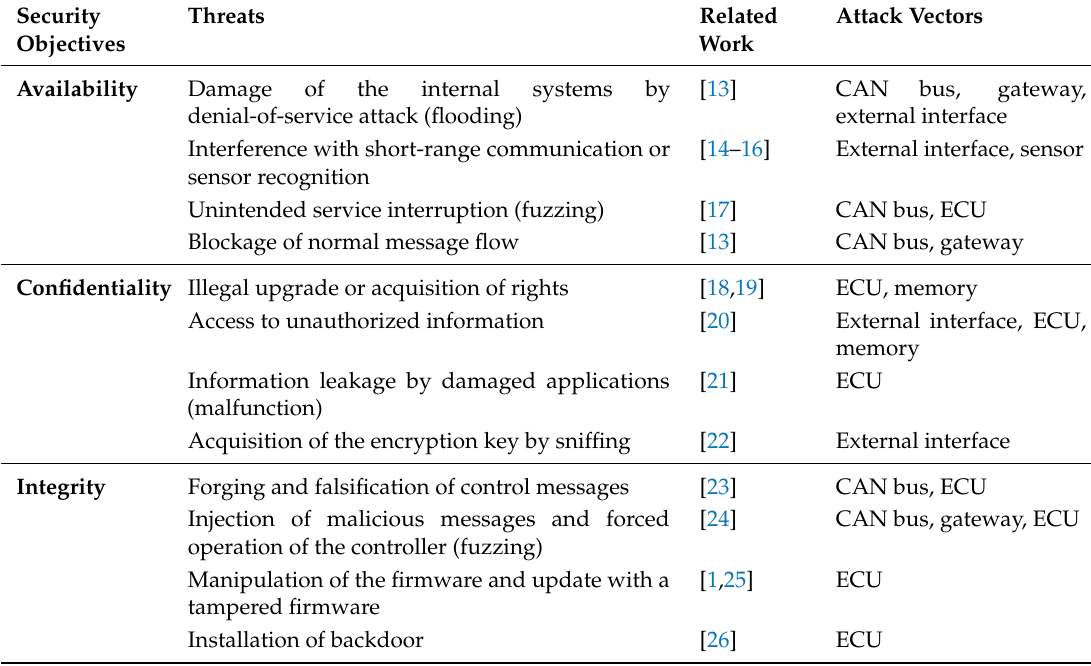
Table 1. Summary of security objectives and corresponding threats on in-vehicle